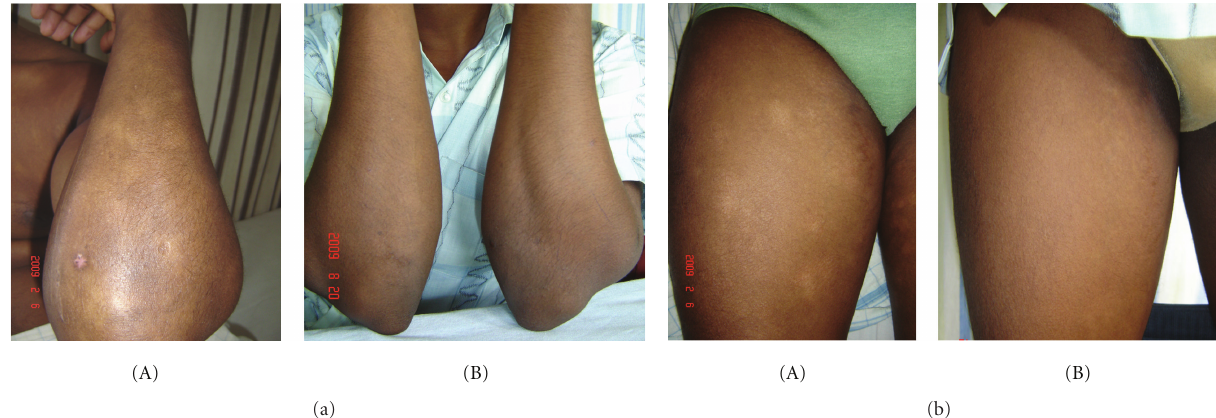
Figure 2: (a) A 29-year-old man had hypopigmented, finely wrinkle, slightly scaly patches without telangiectasia or induration on bilateral forearm and trunk. (b) Similar lesions on thigh bilaterally. (A) Before therapy and (B) complete clinical response after 30 sessions of PUVA (patient 2).